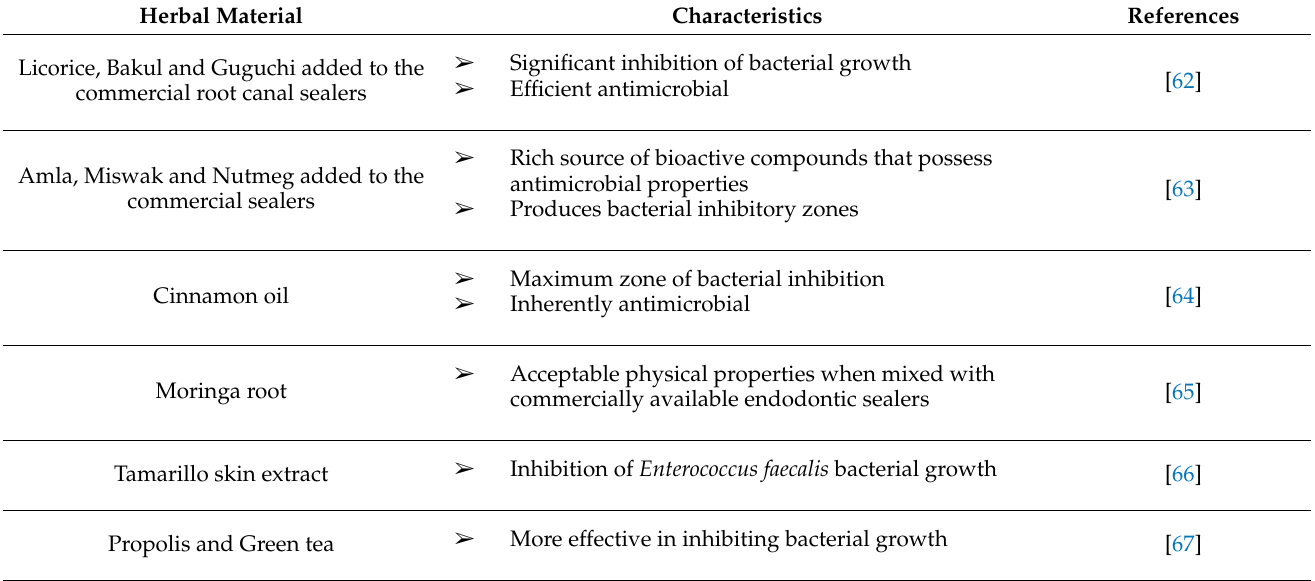
Table 5. Studies related to the use of herbal medicine in combination with commercially available endodontic